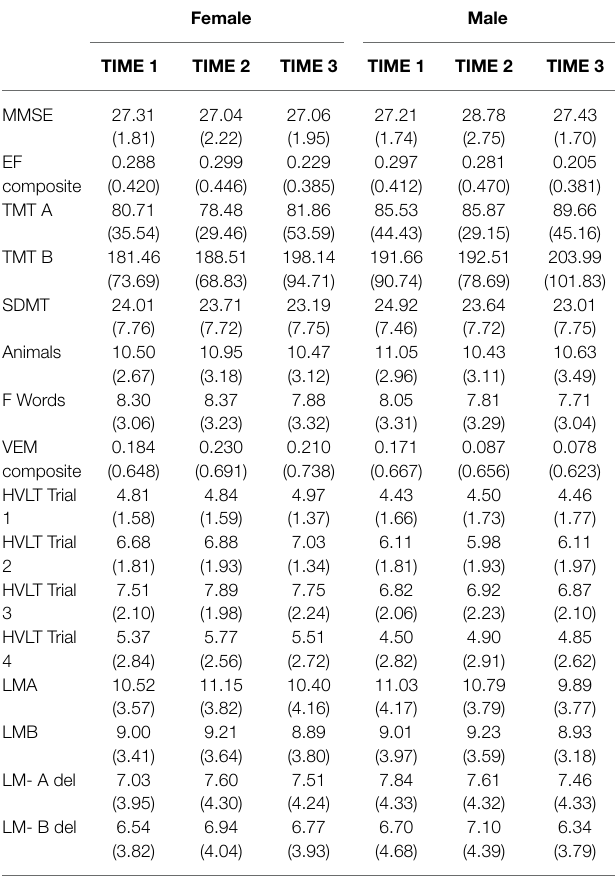
TABLE 3 | Means and standard deviations on MMSE, Executive Functioning (EF) tasks and Verbal Memory tasks by Age and Educational Group by sex groups and